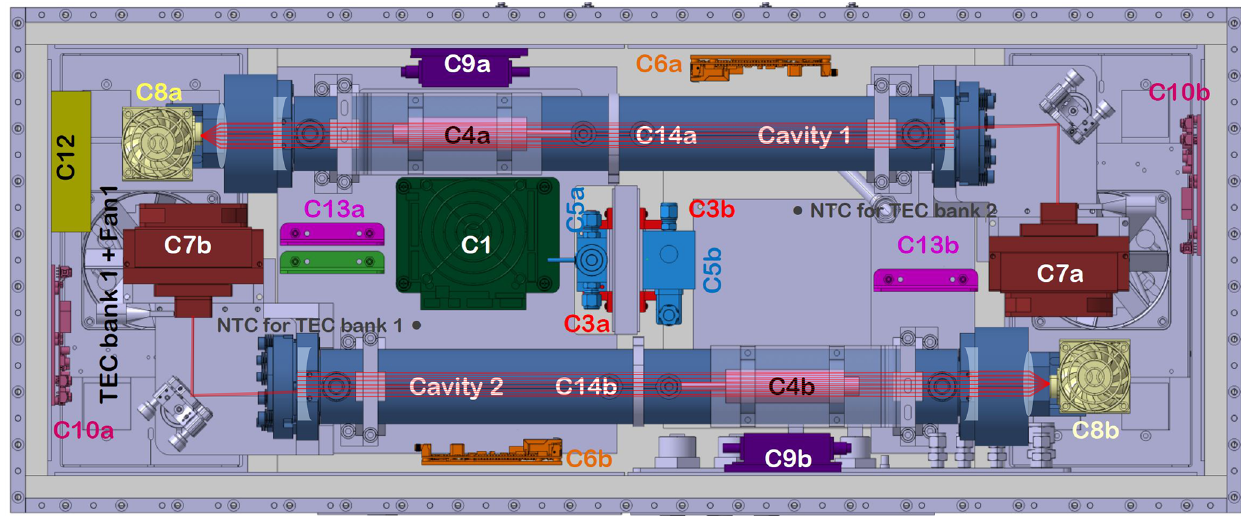
Figure 2. ICOS arrangement inside the AMICA enclosure. Labelled components are described in Table 2. Also shown are optical elements attached to the cavity (high-reflectivity (HR) mirrors and collimating lenses) in light blue and approximations of optical beam paths in red.